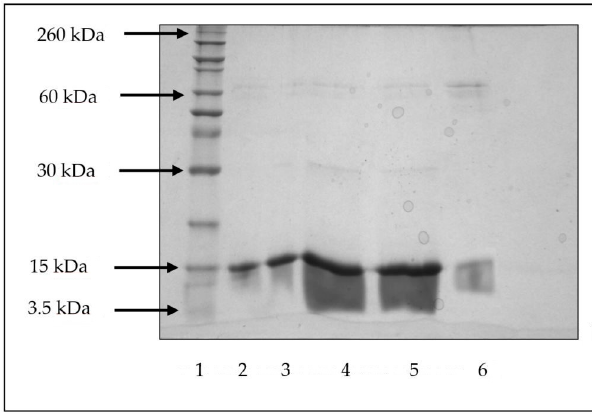
Figure 6. Polyacrylamide Gel Electrophoresis (SDS-PAGE) of lysozyme extracted and released from double-walled microspheres. Lane 1: standard molecular weight marker ( M w range: 3.5–260 kDa); Lane 2: fresh lysozyme standard; Lane 3: lysozyme extracted from microspheres prepared without excipients; Lane 4: day 1 released lysozyme from microspheres prepared without excipients; Lanes 5–6: day 1 and day 42 released lysozyme from microspheres prepared with 1% PVA ( w / v ) in